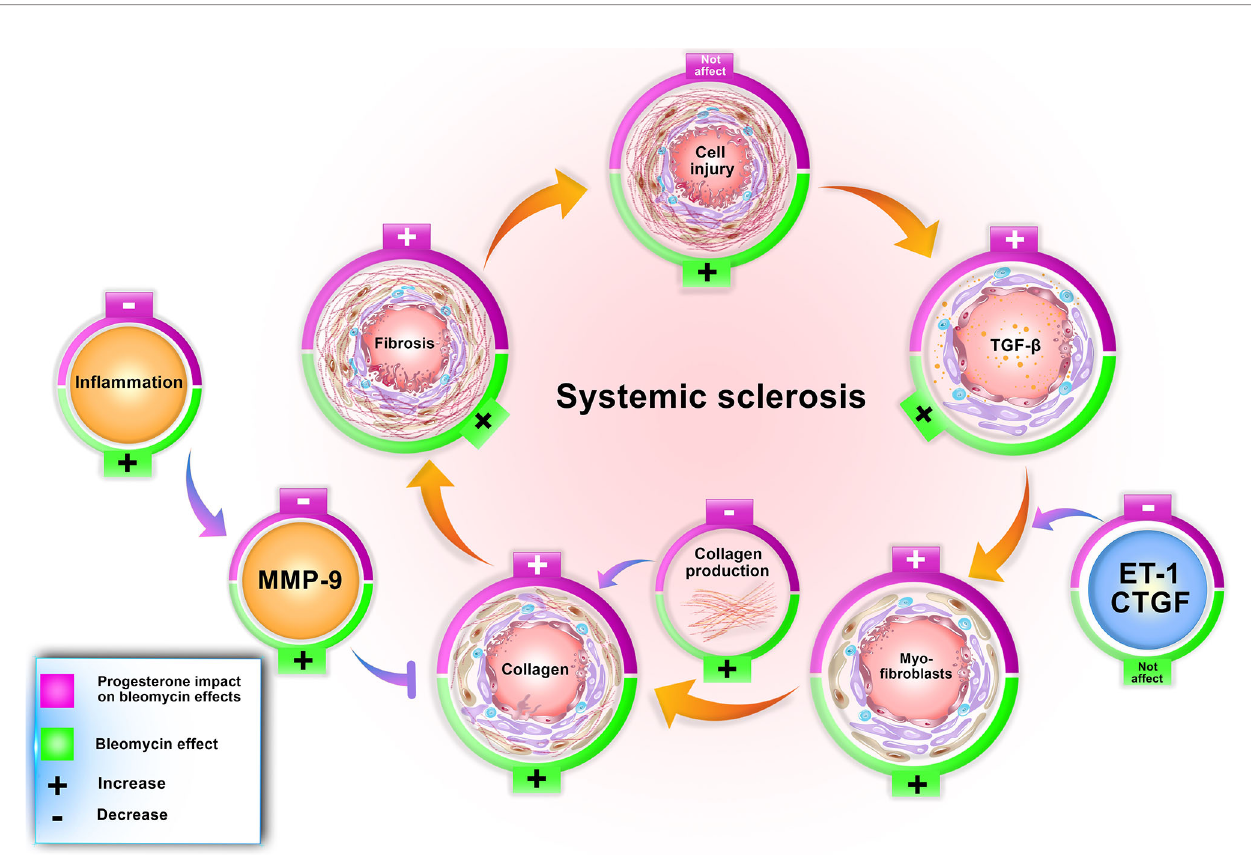
FIGURE 6 | Progesterone aggravates lung fi brosis in bleomycin - induced systemic sclerosis model. Progesterone by increment of the TGF- b , myo fi broblasts, and decrement of MMP9 and in fl ammation augments collagen content in fi brotic lung tissues, therefore aggravates fi brosis. ET, Endothelin; CTGF, connective tissue growth factor; MMP, matrix